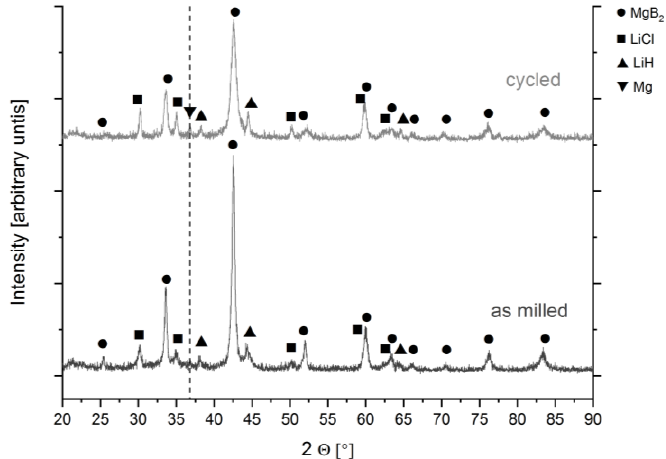
Figure 6. XRD patterns of the sample after milling (as milled) and after the second hydrogenation and dehydrogenation (cycled).